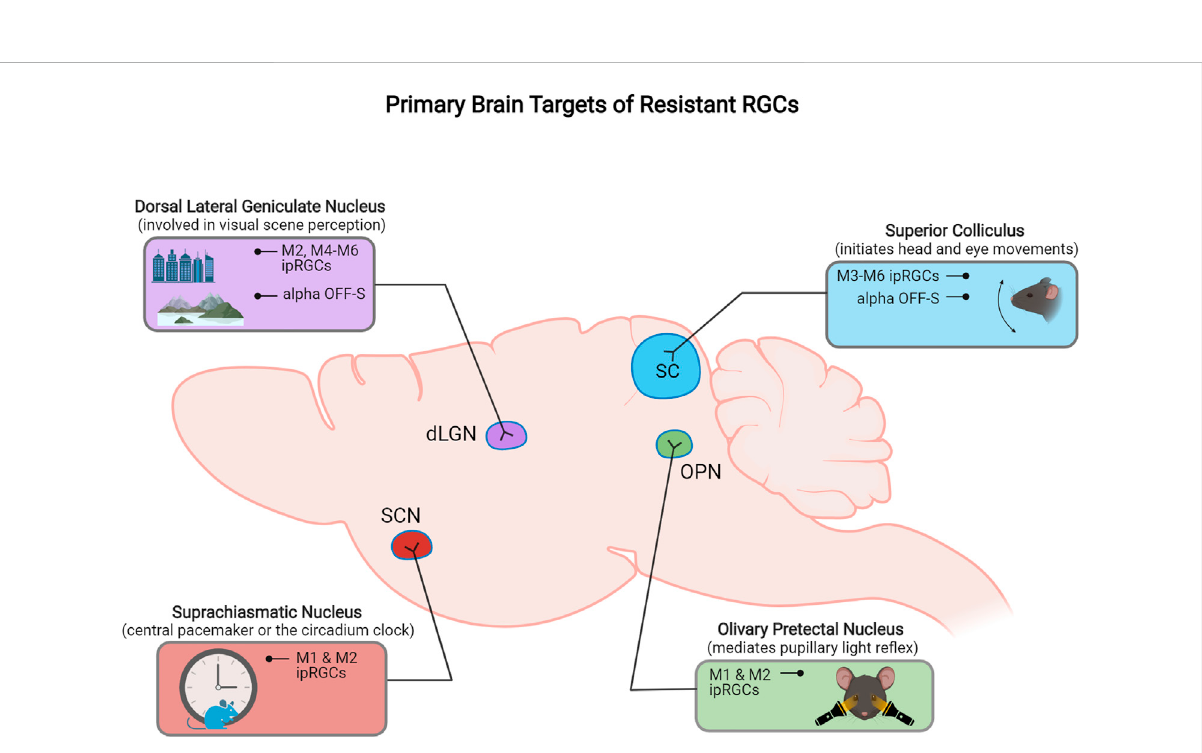
FIGURE 2 Schematic representation of the primary retinorecipient areas innervated by different resistant RGC subtypes.